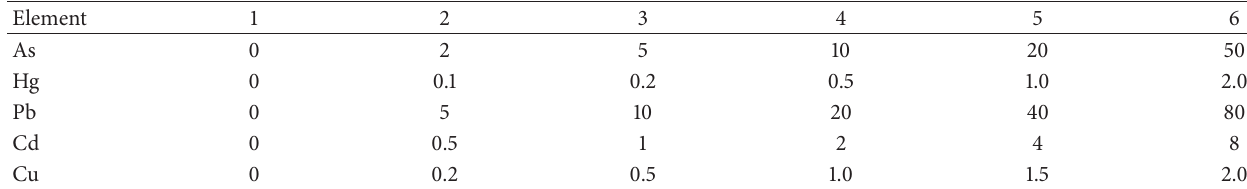
Table 2: The preparation of calibration solutions of heavy metals.